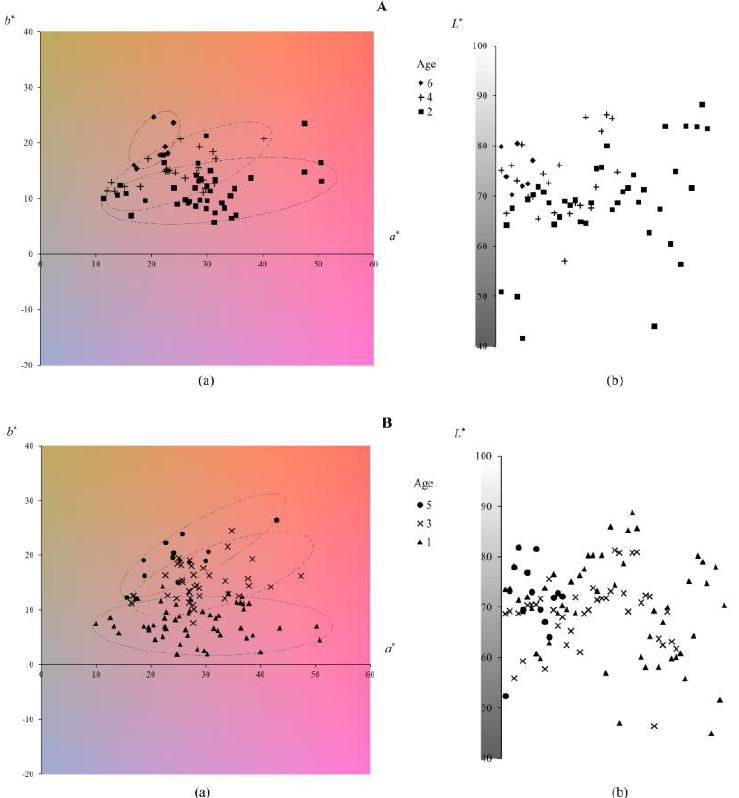
Figure 4. Chromaticity ( a ) and lightness ( b ) distinction of 70 red wine samples in group A ( A ) and 105 red wine samples in group B ( B ) of different ages. Dotted ellipses on the chromaticity plane mark the concentrated distribution of wine samples of each age.